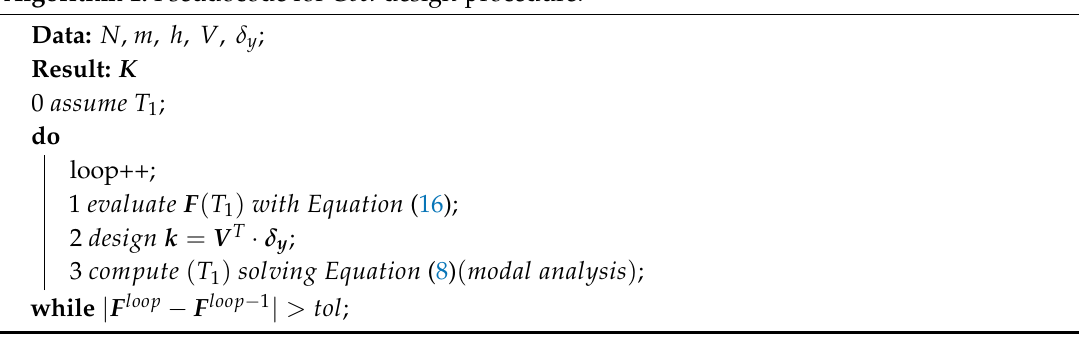
Algorithm 1: Pseudocode for Goel design-procedure.